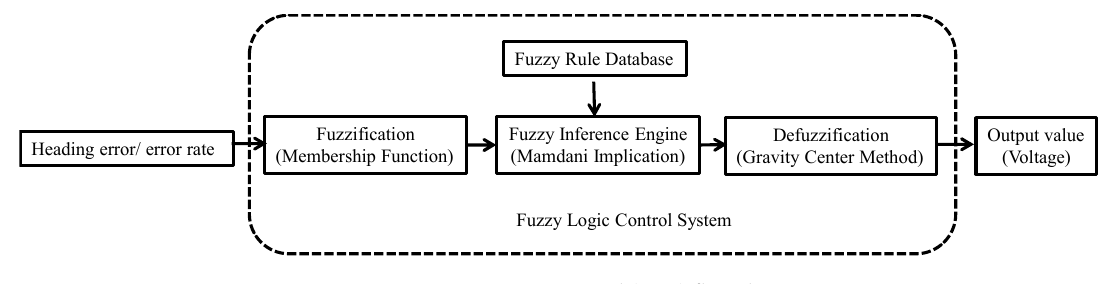
Figure 2. Fuzzy Logic Control (FLC) flowchart.